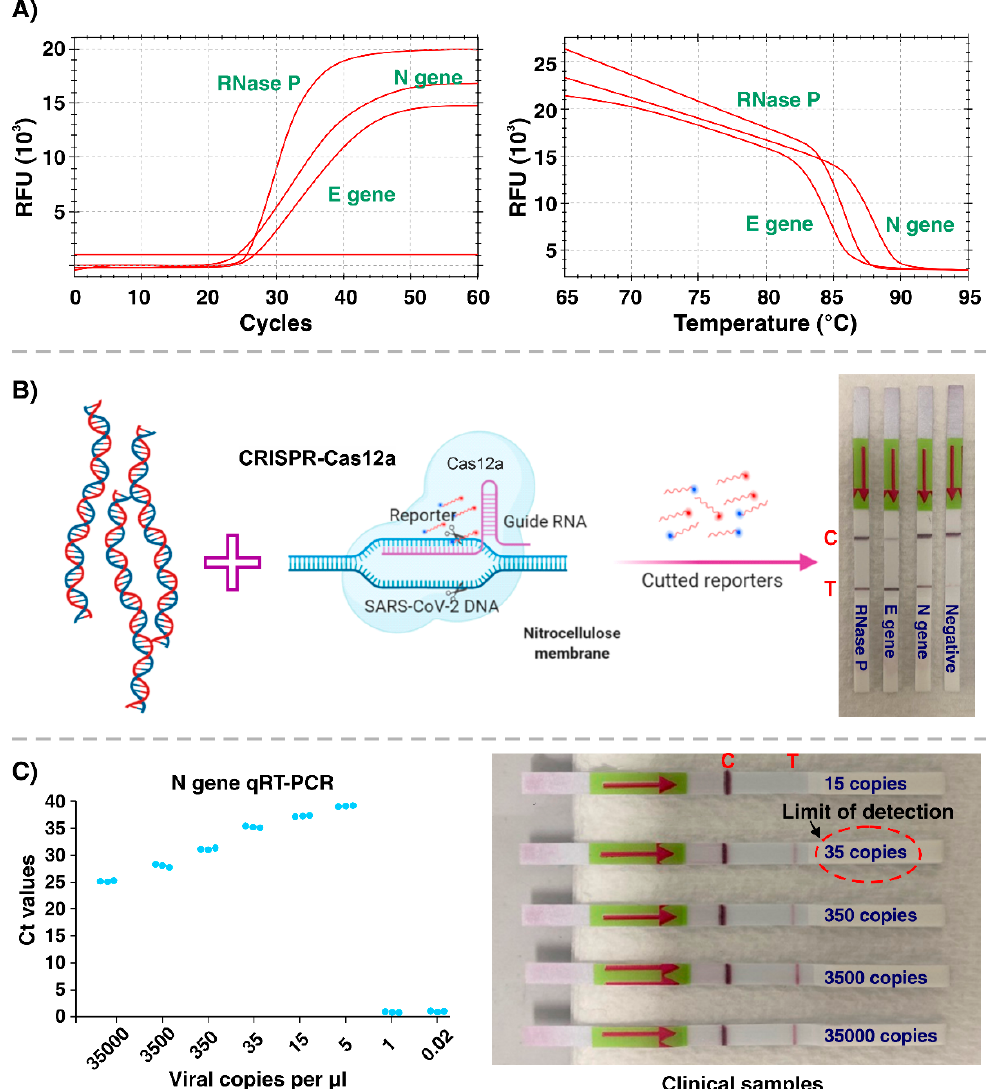
Figure 1. ( A ) RT-LAMP reaction performed in an RT-qPCR machine using N, E, and RNase P primers at an optimal temperature and time. ( B ) Schematic illustration of CRISPR-Cas12a reaction on pre-amplified SARS-CoV-2 target genes, followed by visualization with lateral flow strips. ( C ) The detection limit of the RT-qPCR assay ( left ) using PCR machine and RT-LAMP/Cas12a assay ( right ) using clinical samples.